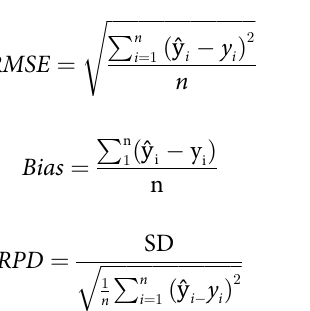
ffiffiffiffiffiffiffiffiffiffiffiffiffiffiffiffiffiffiffiffiffiffiffiffiffiffiffiffiffi P n